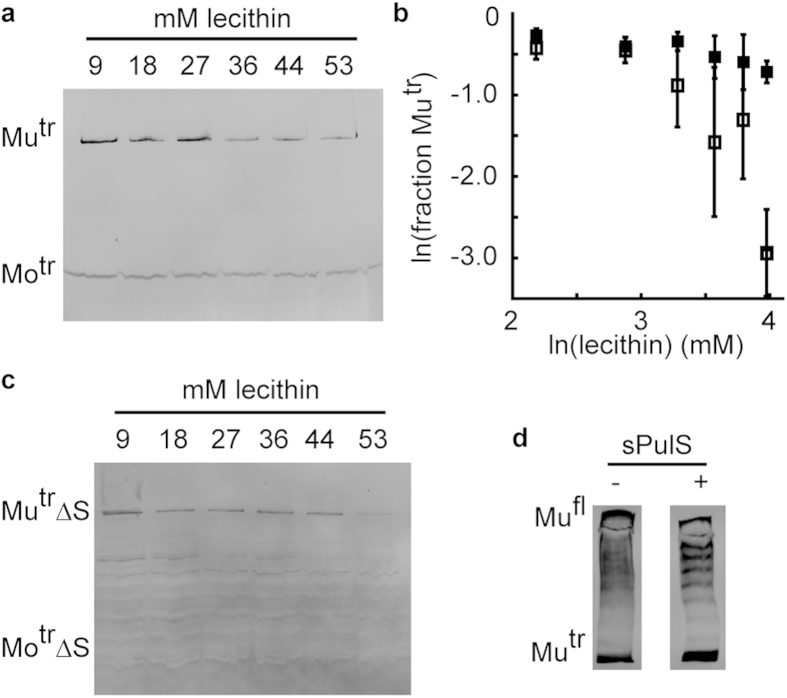
Effect of sPulS on PulD folding.(a) Initial multimerisation of PulD28–42/259–660 in the presence of 0.2 μg/μl sPulS and increasing quantities of lecithin (as indicated) after 6 min of PulD-synthesis. (b) Double logarithmic plot of the initial multimerisation of PulD28–42/259–660 (◼) in (a). Errors represent S.D. over 3 independent measurements. Initial PulD multimerisation in the absence of sPulS is also shown (◻) (from ref. 29). (c) Initial multimerisation of PulDΔS28–42/259–598 in the presence of 0.2 μg/μl sPulS and increasing quantities of lecithin (as indicated). PulDΔS28–42/259–598 degradation results in multiple bands below the multimer (MutrΔS); the approximate position of the monomer is indicated (MotrΔS). (d) Mixed multimer formation between PulD28–42/259–660 and and PulDfl in equimolar ratios in the presence of 53 mM lecithin and 0.2 μg/μl PulS as indicated. Mutr and Motr indicate the migration position of multimeric and monomeric PulD28–42/259–660 species, respectively. Mufl indicates the position of full-length PulD.